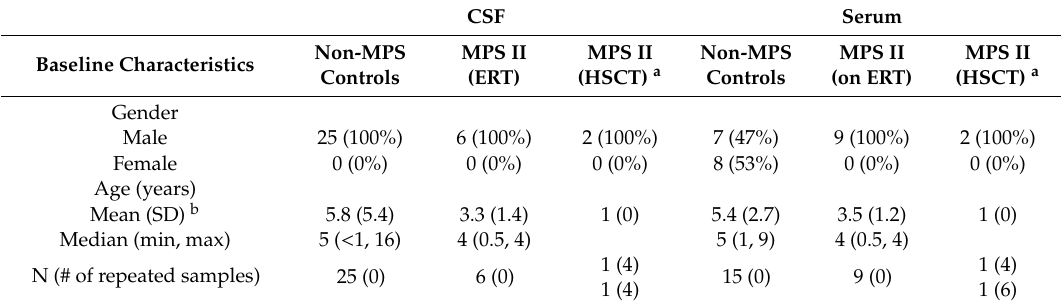
Table 1. Summary of patient demographics and baseline